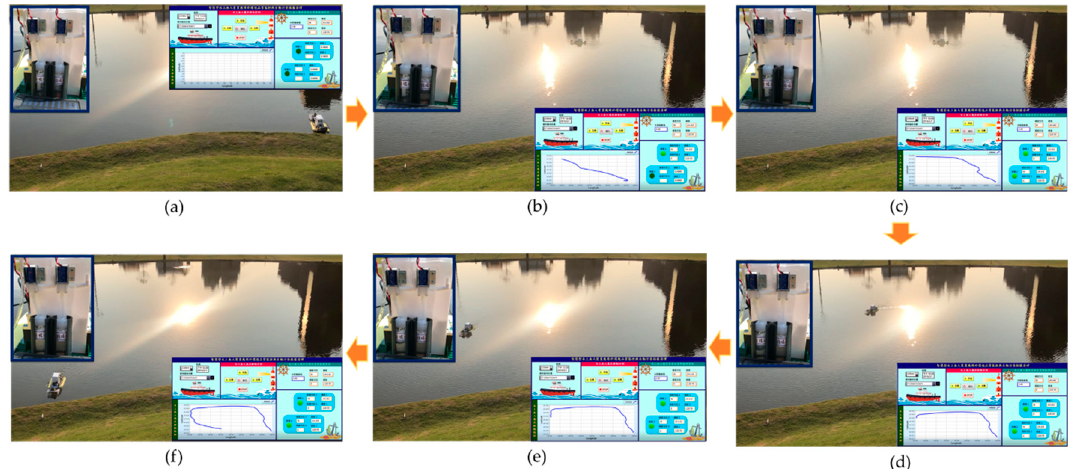
Figure 17. Sailing movement trajectory of the MF-USV. ( a ) The MF-USV was located at the start point. ( b ) When the water pH value at the first location was higher than 8.5 or lower than 6.5, the water was sampled by the water pump. ( c ) The MF-USV leaved the present water sampling point. ( d ) The MF-USV went ahead to search the next contaminated water point. ( e ) The contaminated water field at the second location was detected by the pH sensor and sampled by the water pump. ( f ) The water samples were conveyed to the initial location.